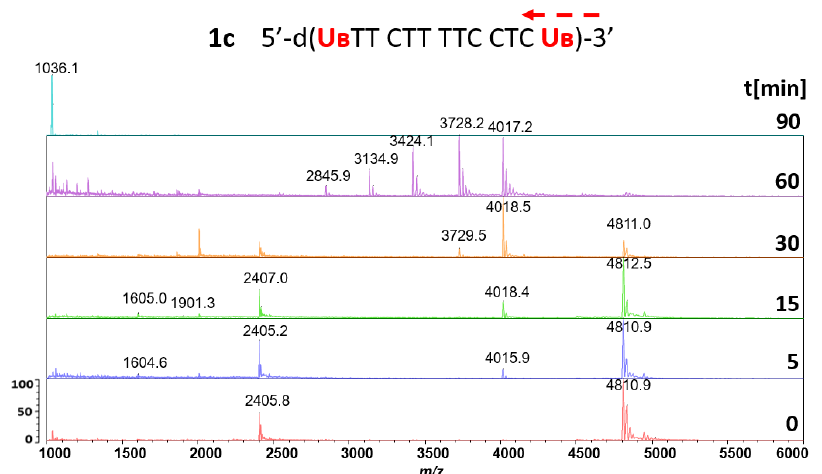
Figure 4. MALDI-TOF mass spectra of the hydrolysates of oligonucleotide 1c after 0, 5, 15, 30, 60 and 90 min of treatment with svPDE. The experimental conditions are described in the Materials and Methods section.